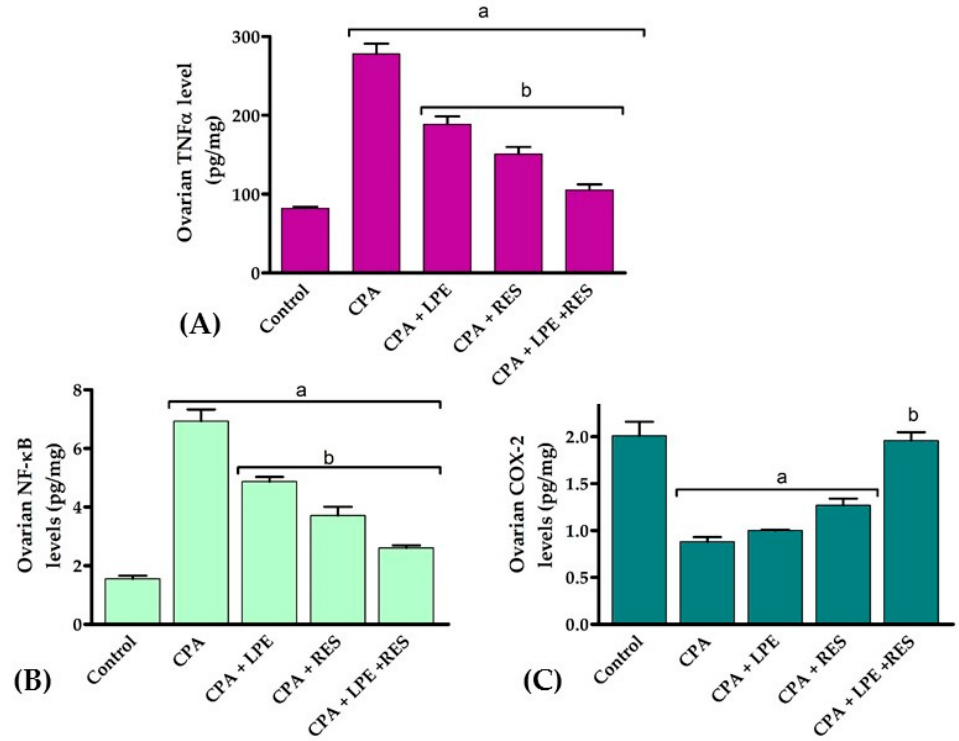
Figure 3. Effects of LPE and/or RES on ovarian tissue inflammation markers in cyclophosphamide- treated rats. ( A ) TNF- α levels, ( B ) NF- κ B and ( C ) COX-2 levels. Data expressed as mean ± SEM. a p < 0.05 versus control group; b p < 0.05 versus a CPA group, (n = 7). CPA: Cyclophosphamide, LPE: Lemon peel extract, RES: resveratrol.